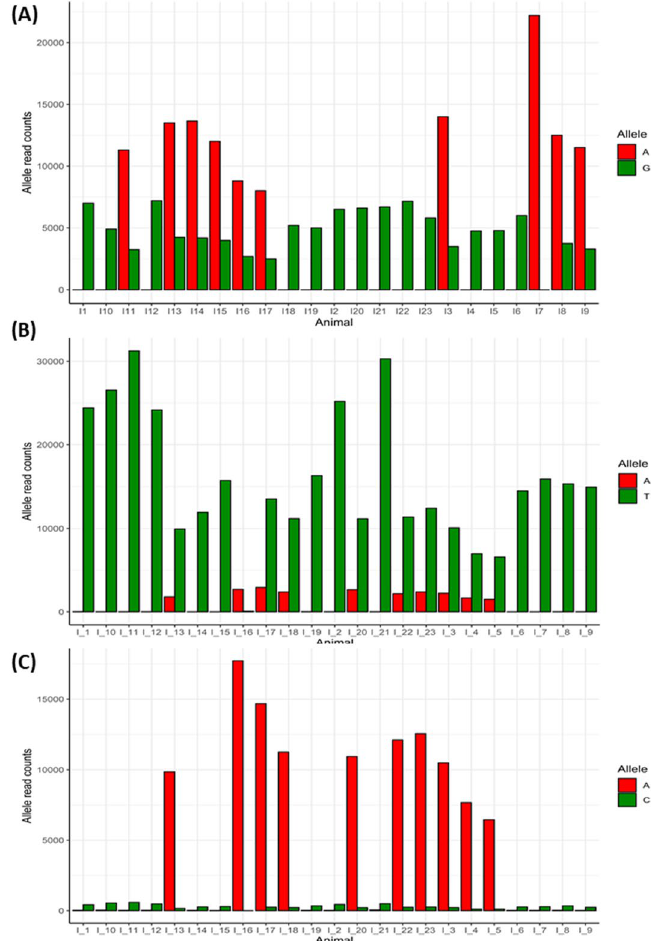
Figure 4. Allele specific expression (ASE) analysis results. Bar plots showing the allele specific expression results for BF2 (5A), BLB1 (5B) and BLB2 (5C) genes. Each column represents gene expression levels, measured as read counts, for each allele (reference (red) vs non-reference (green) allele). Gene expression levels have been plotted against each individual animal.